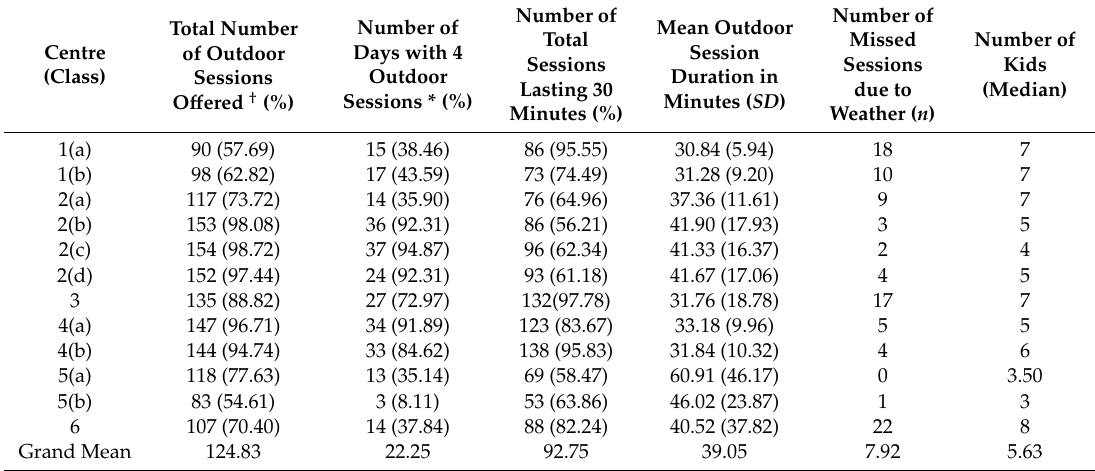
Table 4. Adherence to four 30-min daily outdoor periods by experimental centres